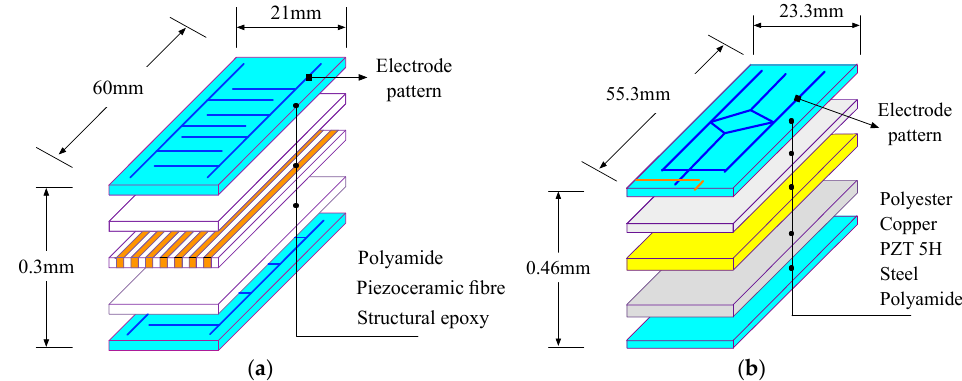
Figure 1. Schematic diagram for the construction of the piezoelectric laminated products. ( a ) MFC patch; ( b ) PPA patch.